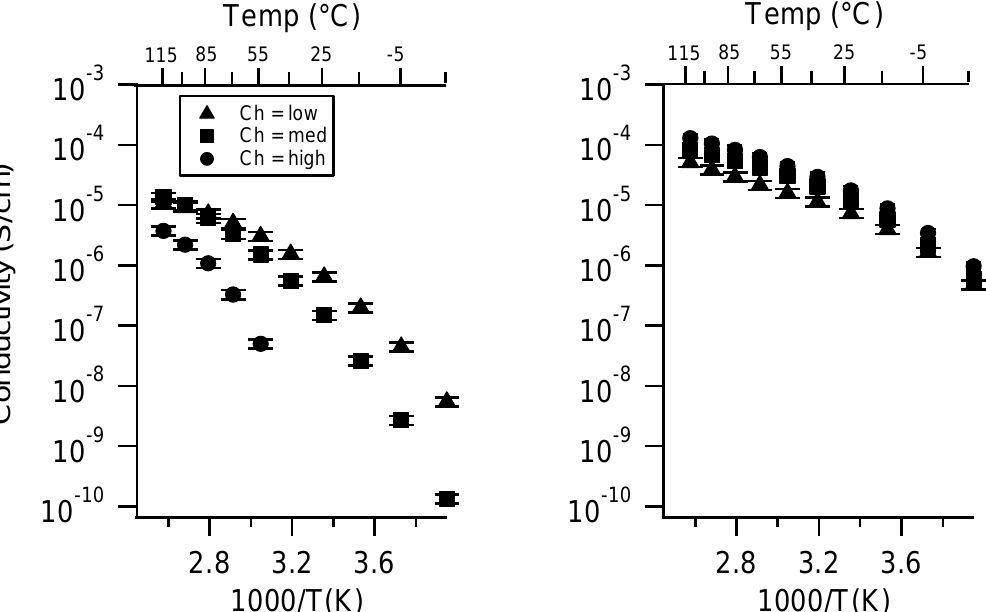
Figure A15. Conductivity as a function of charge density for PEGDMA1000_SSK (left) and PTHFDA1000_STFSIK (right) SIPEs swelled with TEG. Temperatures ranged from − 20 °C to 115 °C. Note that there may be a non-negligible fraction of electronic conductivity in conditions where conductivity of less than 10 − 9 S/cm is reported.